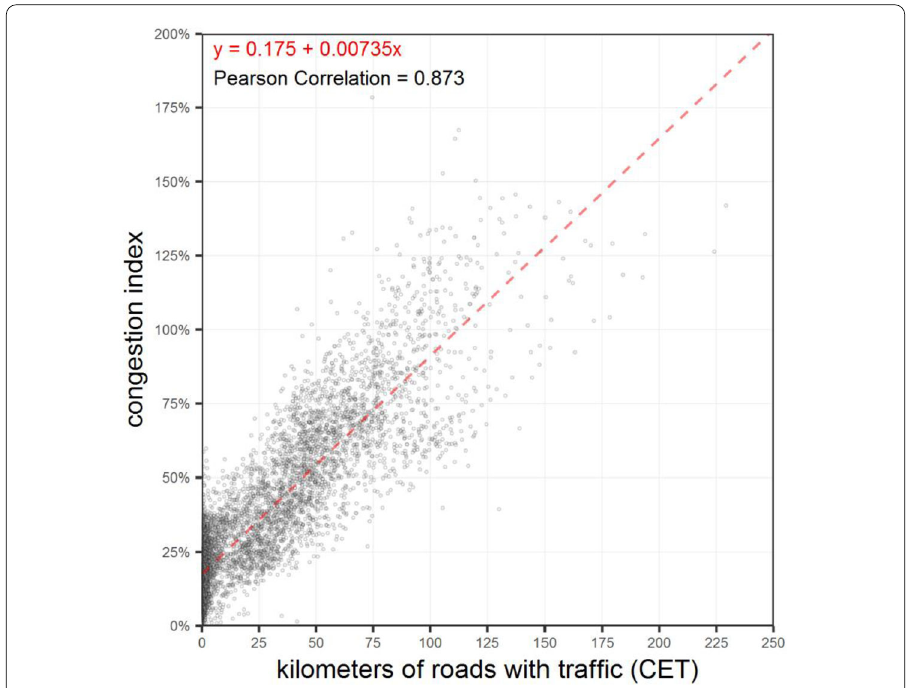
Figure 5 Dispersion graph—travel time index and kilometers of congestion (CET)—Business Days 2016–2018. Each point represents the value of both variables for the 2016–2018 business days. The dashed red line is the prediction of the bivariate model that estimates the congestion index based on the kilometers of slowness plus an